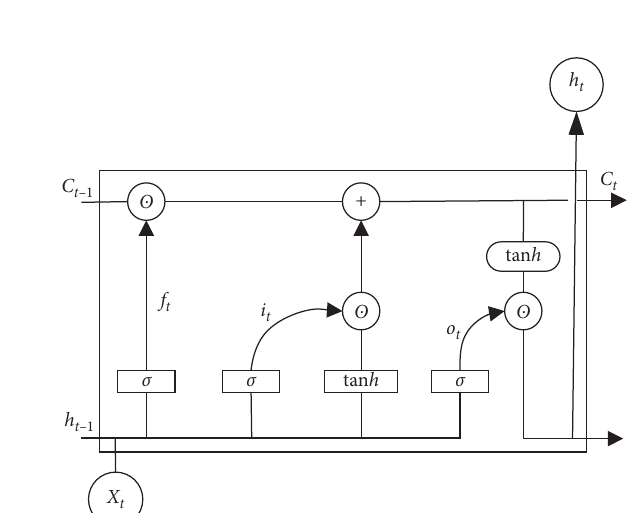
Figure 16: LSTM-GASVR structure.